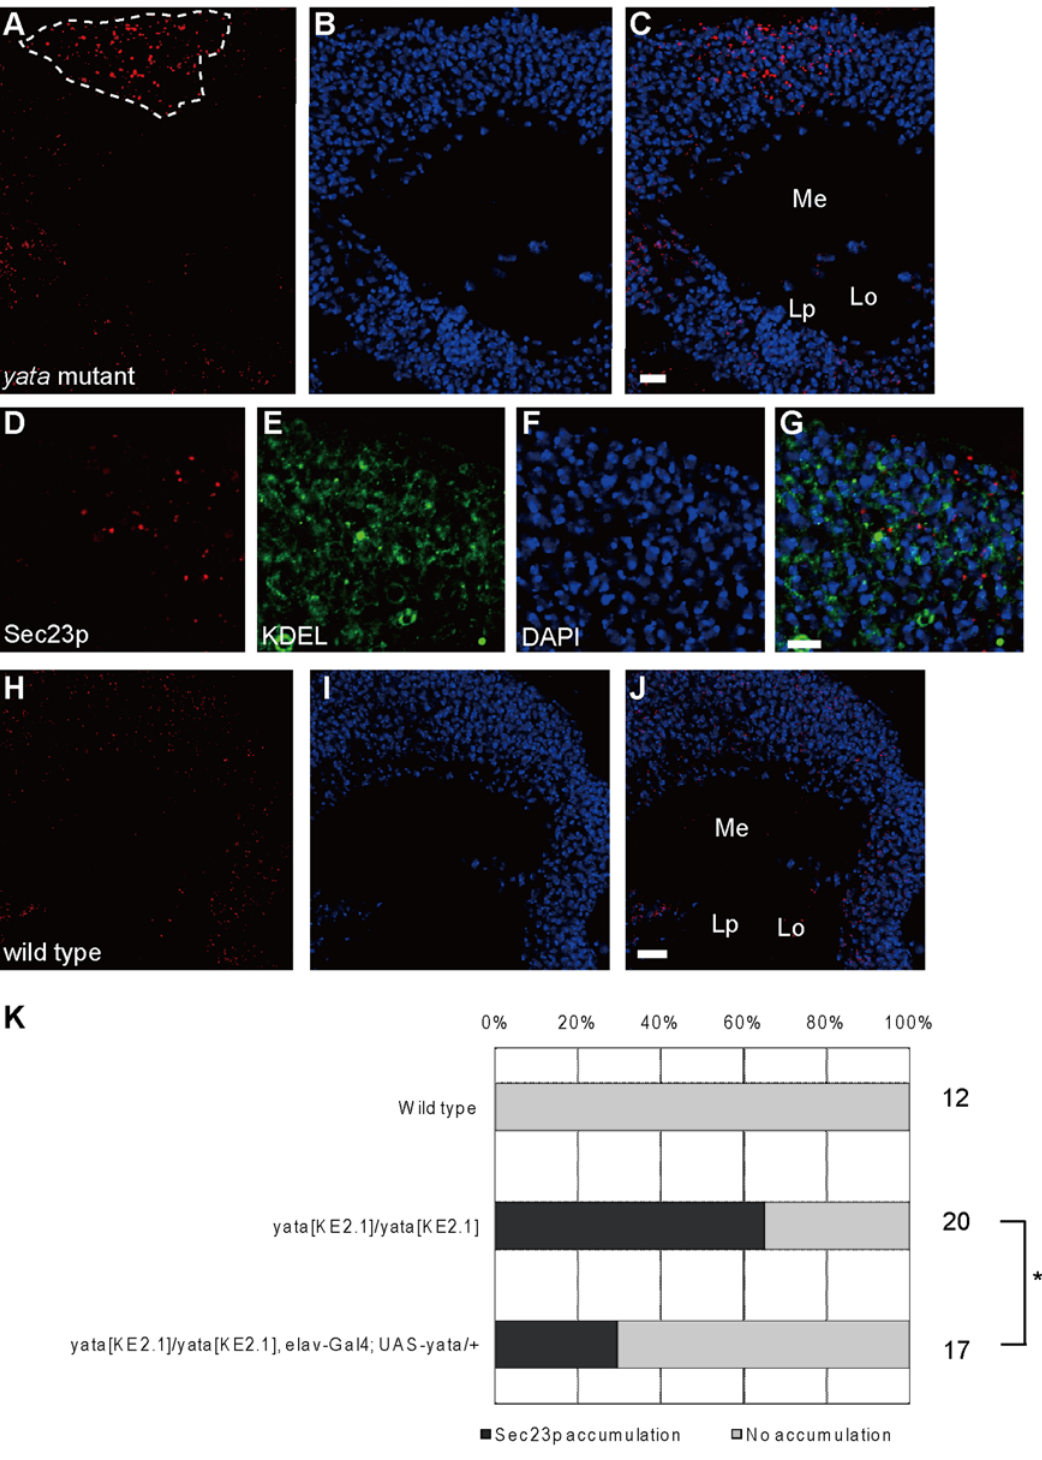
Figure 7. Aberrant accumulation of Sec23p in the yata mutant. (A–C) Mid pupal brain of the yata mutant stained with anti-Sec23p (A) and DAPI (B). Aberrant accumulation of Sec23p was observed in a restricted region (surrounded by dotted line in A). (D–G) Magnified image stained for anti-Sec23p (D), anti-KDEL (E) and DAPI (F). (H–J) Wild-type brain stained with anti-Sec23p (H) and DAPI (I). Me: medulla, Lo: lobula, Lp: lobula plate. Scale bars: 10 m m in (C) and (J), 5 m m in (G). (K) Summary of Sec23p accumulation phenotype. Ratios of the number of optic lobes that showed the accumulation of Sec23p are shown. The numbers of examined optic lobes are also indicated. *: p , 0.05 (chi-square test). All of the data were collected from flies of the same genetic background.